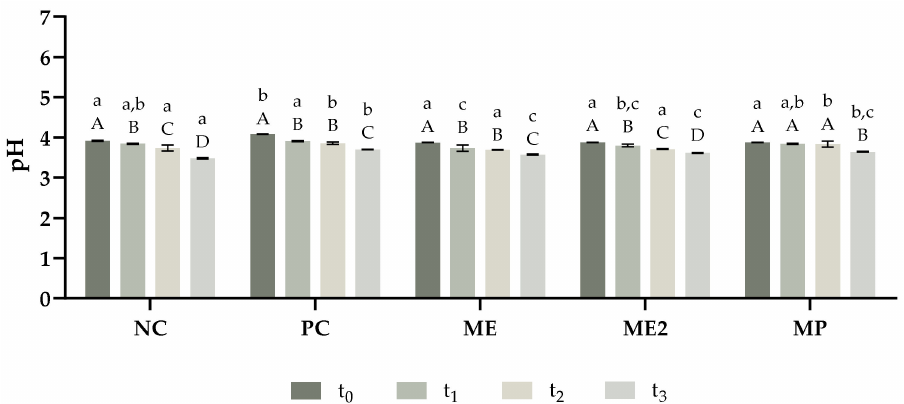
Figure 4. pH variation of the yoghurts throughout the period of the study. The analysis was performed in different timepoints: t 0 —after production; t 1 —two weeks after production; t 2 —four weeks after production; and t 3 —eight weeks after production. NC—yoghurt with no additives (negative control); PC—yoghurt with sorbic acid (positive control); ME—yoghurt with 1 g/L of M. oleifera extract; ME2—yoghurt with 2 g/L of M. oleifera extract; MP—yoghurt with 2.9 g/L of M. oleifera leaf powder. The results are expressed as means ± standard deviations of 3 independent measurements obtained from the same sample. Different lowercase letters (a–c) represent statistically different values ( p < 0.05) for the same timepoint. Different capital letters (A–D) represent statistically different values ( p < 0.05) for the same